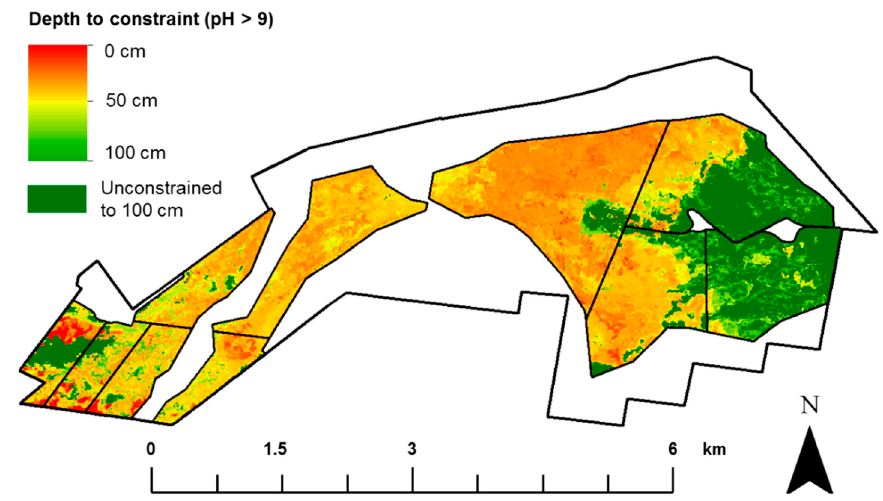
Figure 5. Boxplots of the distribution of soil pH (1:5 H 2 O) with depth for 110 soil cores taken from cropping fields at L’lara. Solid black lines inside boxes represent median values, and the dashed, vertical grey line indicates the pH (H 2 O) threshold of nine, deemed to have potential constraining effects on crop growth.